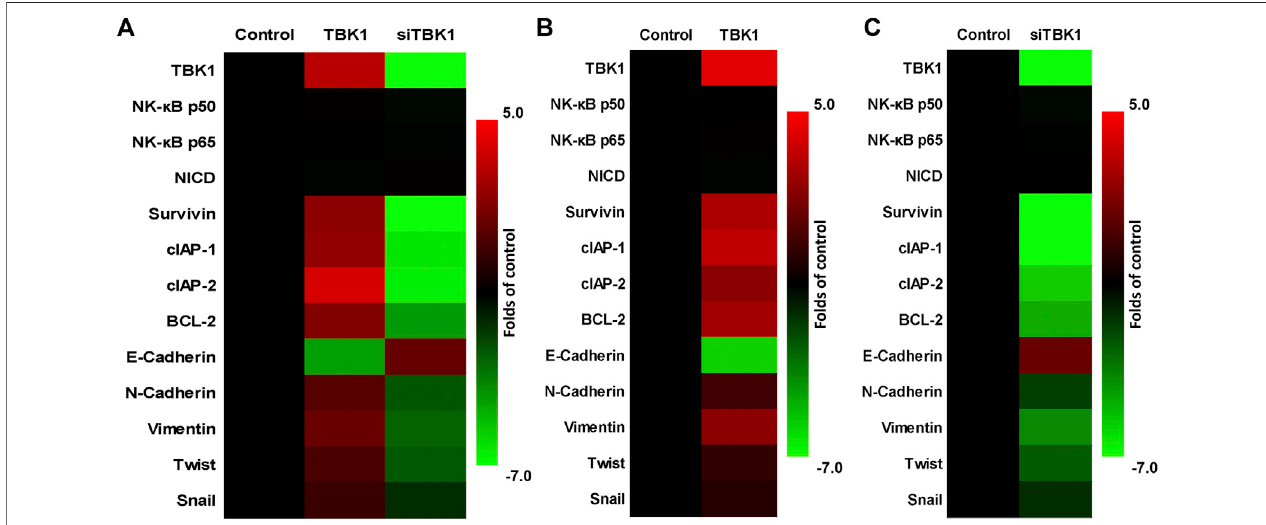
FIGURE3| Theeffectof TBK1 onthedrug-resistance-relatedfactorsinHCCcells. (A) HepG2cellsweretransfectedwith TBK1 or siTBK1 andtheexpressionlevel ofdrug-resistance-relatedfactorswereexaminedbyqPCR. (B) MHCC97-Lcellsweretransfectedwith TBK1 andtheexpressionlevelofdrug-resistance-relatedfactors were examined by qPCR. (C) MHCC97-H cells were transfected with si TBK1 and the expression level of drug-resistance-related factors were examined by qPCR. The results are shown as heat-map.